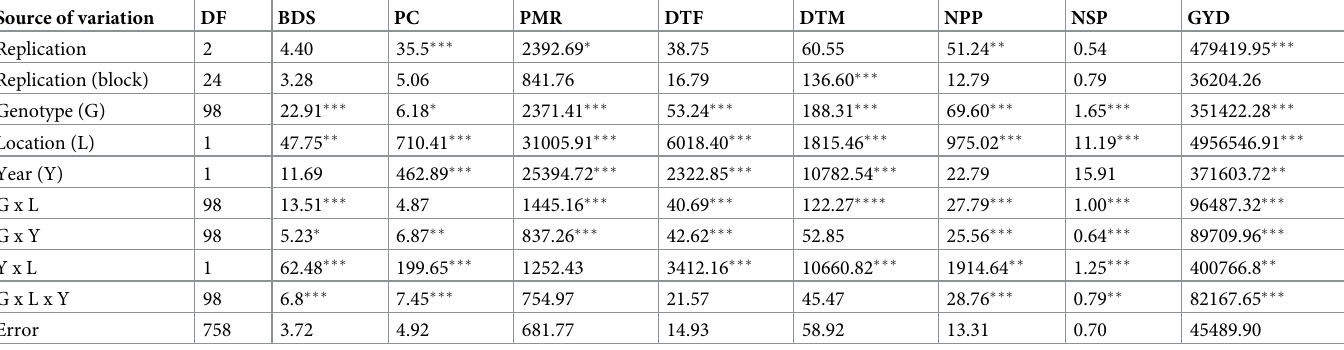
Table 1. Mean squares and significant tests for three bean fly resistance parameters and five agro-morphological traits among 99 common bean genotypes assessed in two locations and two years in Malawi. Source of